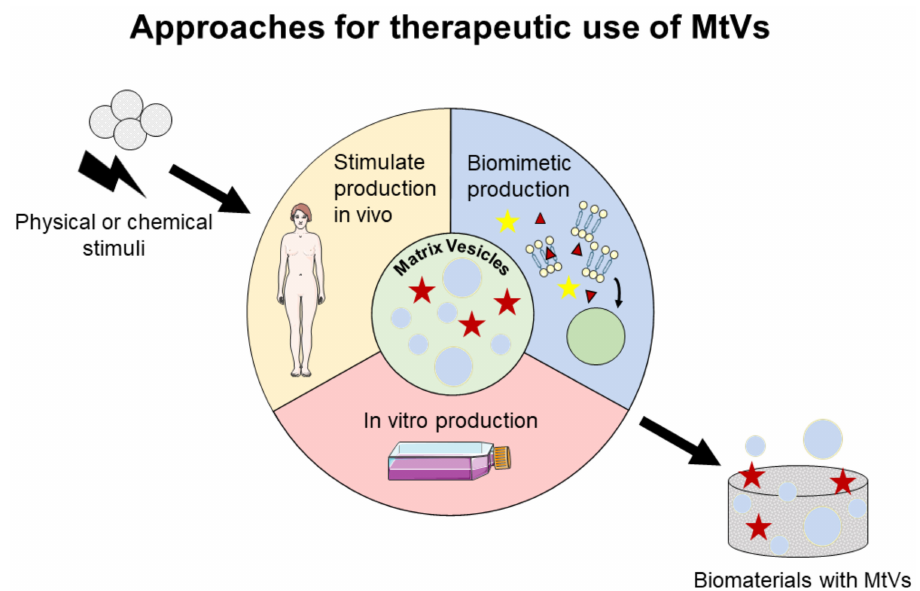
Figure 3. Possible approaches to use MtVs for therapeutics. MtV production can be stimulated in vivo by applying physical or chemical stimuli on MtV-secreting cells. Biomimetic or in vitro produced MtVs could be used in combination with biomaterials, for example. The figure was modified from Servier Medical Art, licensed under a Creative Common Attribution 3.0 Generic License (http://smart.servier.com/, accessed on 20 January